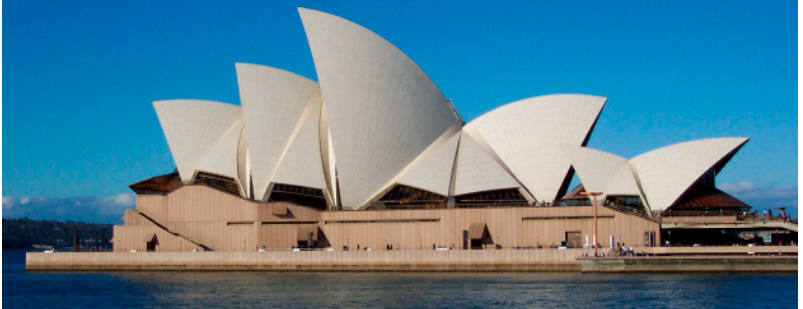
Figure 10. Recent photo of the Opera House.